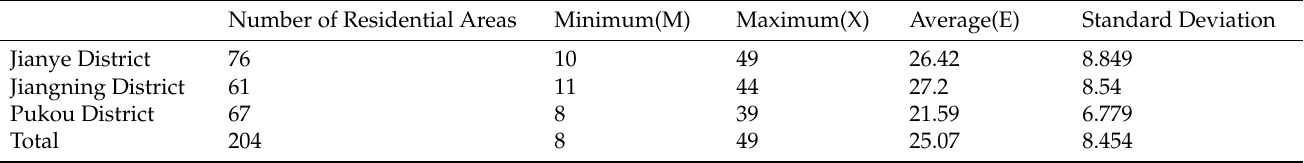
Table 5. Road network density of 204 residential areas in Jiangning, Jianye, and Pukou District.